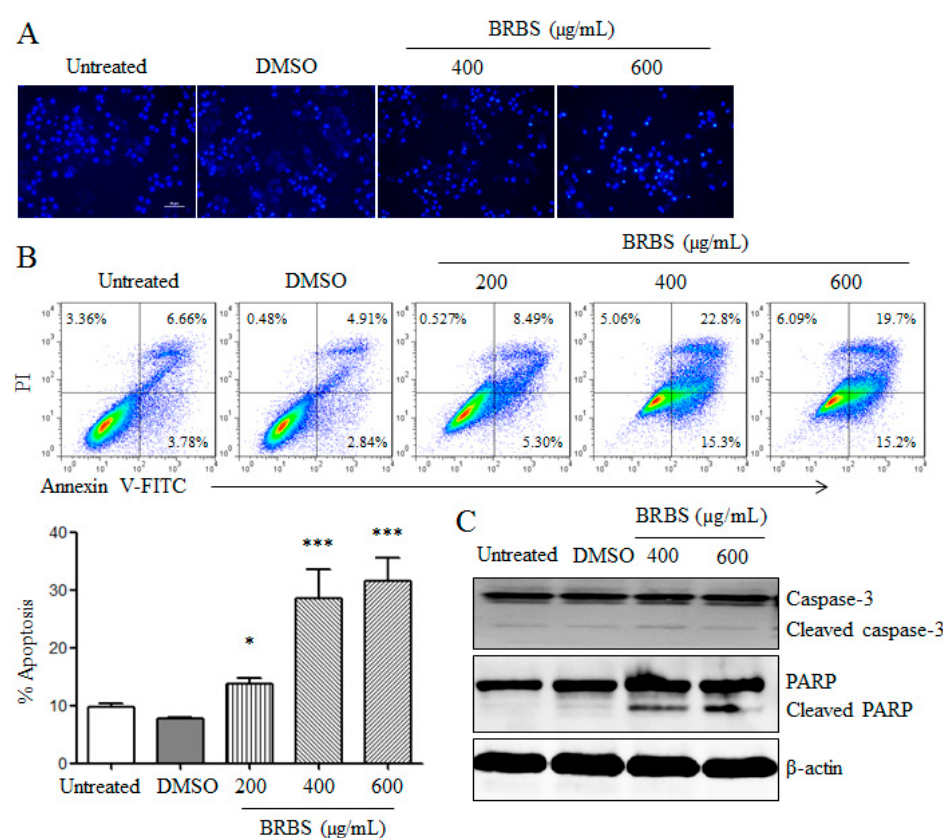
Figure 2. BRBS induces apoptosis of A549 cells. Cells were treated with BRBS for 24 h ( A ) Cells were